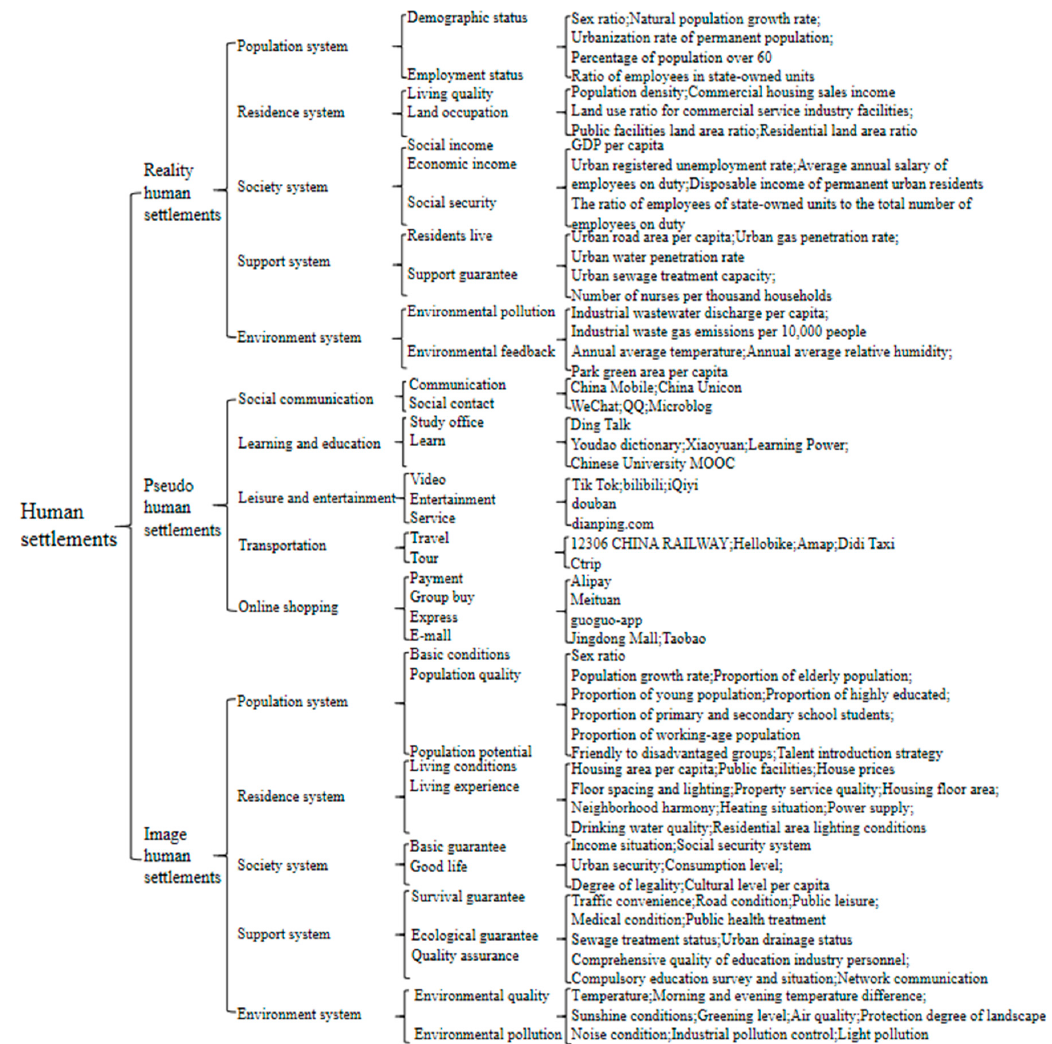
Figure 2. “Three states” human settlements index.